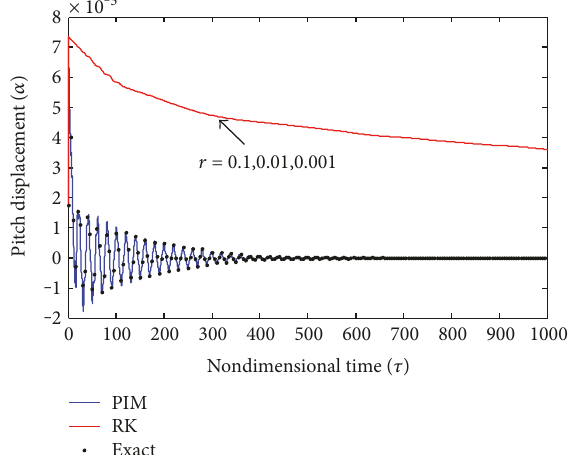
=0.85 in pitch direction provided by PIM, RK, and exact solutions, 0